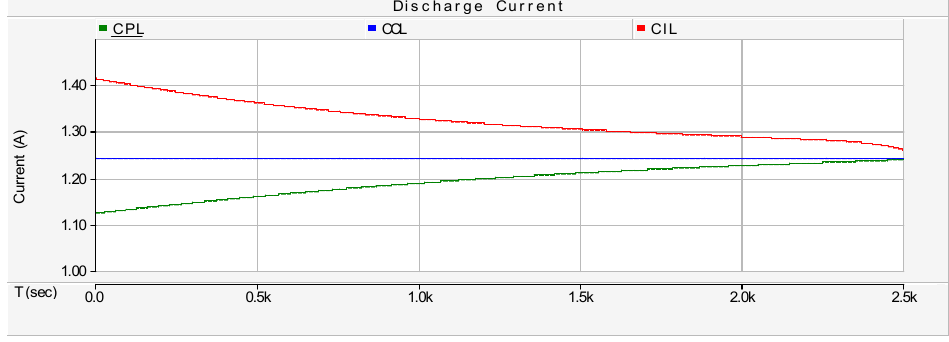
Figure 18. Current profile of battery for the same output ‐ power in all modes.